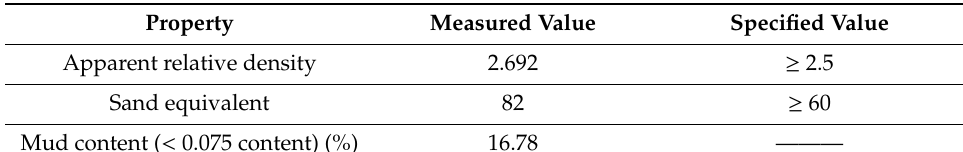
Table 2. Properties of fine aggregate.